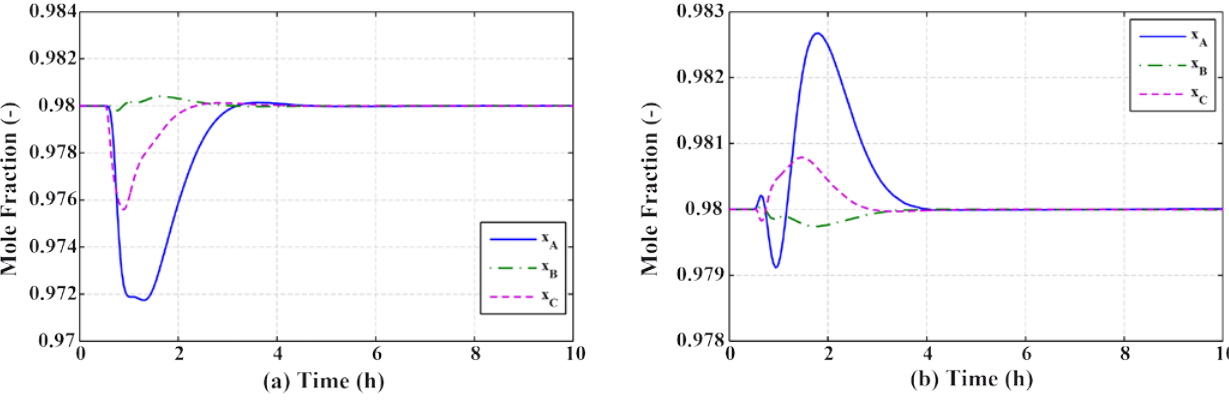
in the feed composition. 𝑥 𝐴